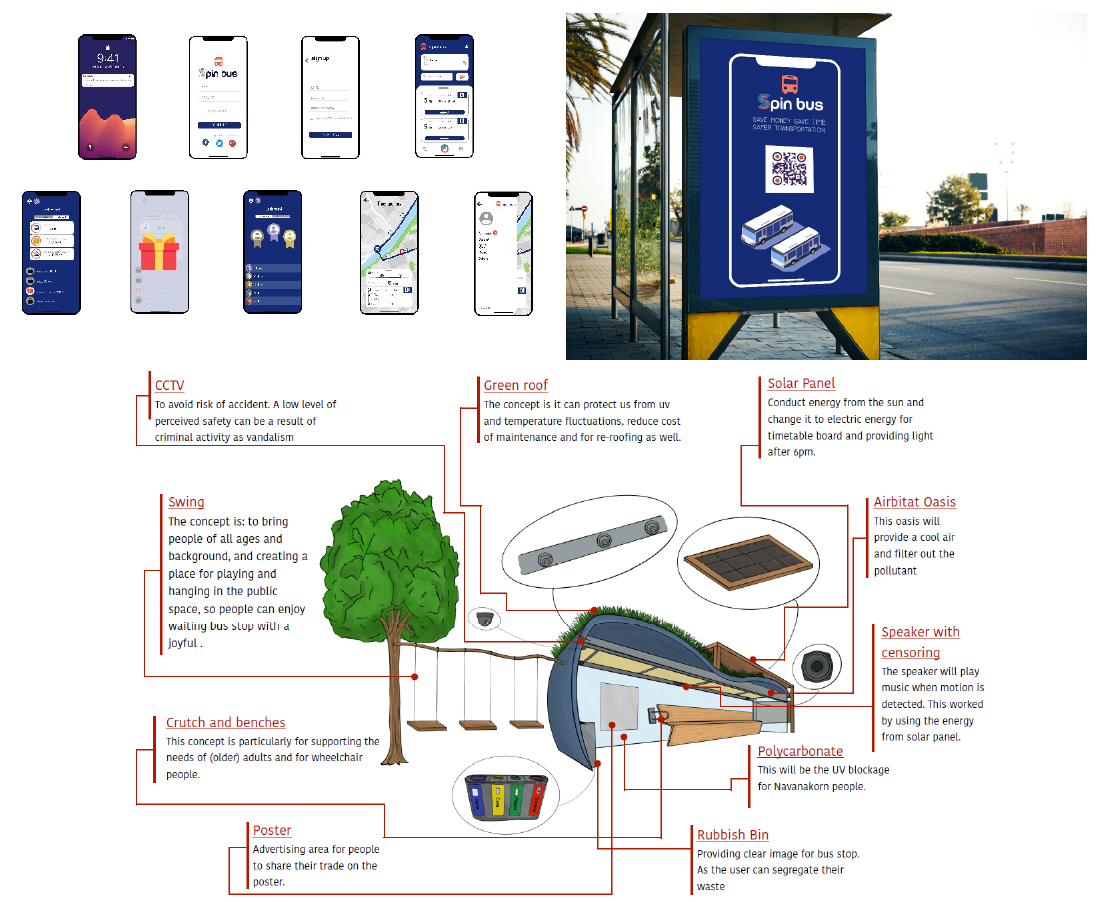
Figure 16. Spin Bus app with multiple windows ( above , left ) and integration of app with bus stop designs ( above , right , and bottom ). Graphics credits to Theera- wan Junditthawong, Sajin Vimolpitayarat, Sakdithat Sopon, Parin Prakitsuwan, Satakamol Patcharatsathien, DBT244 class.